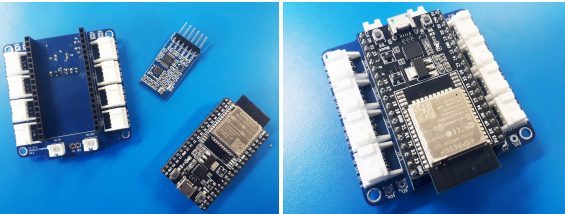
Figure 3. On the left, the internal elements of our low-level unit (the custom support PCB, the integrated IMU and the ESP32 board). On the right: our low-level unit